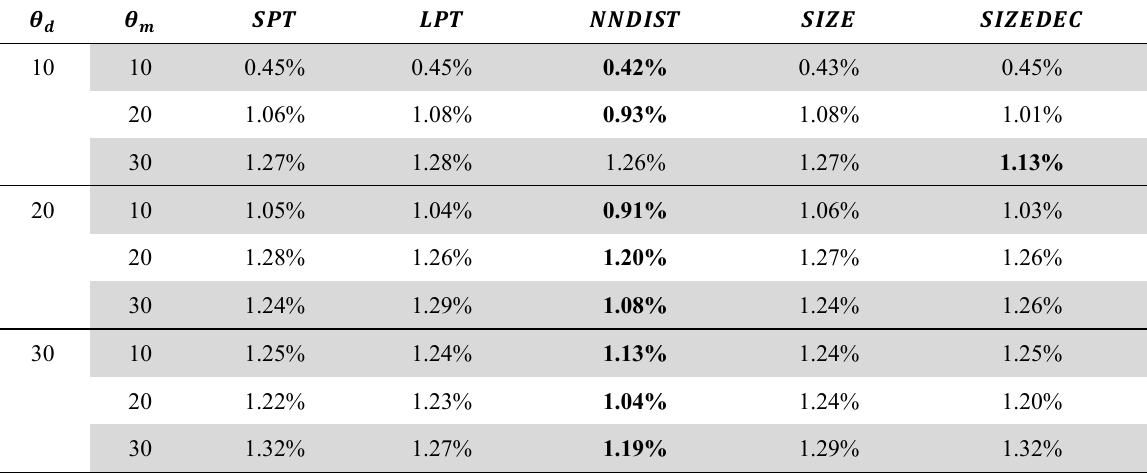
and 𝜃 (cid:3031) (cid:3040)